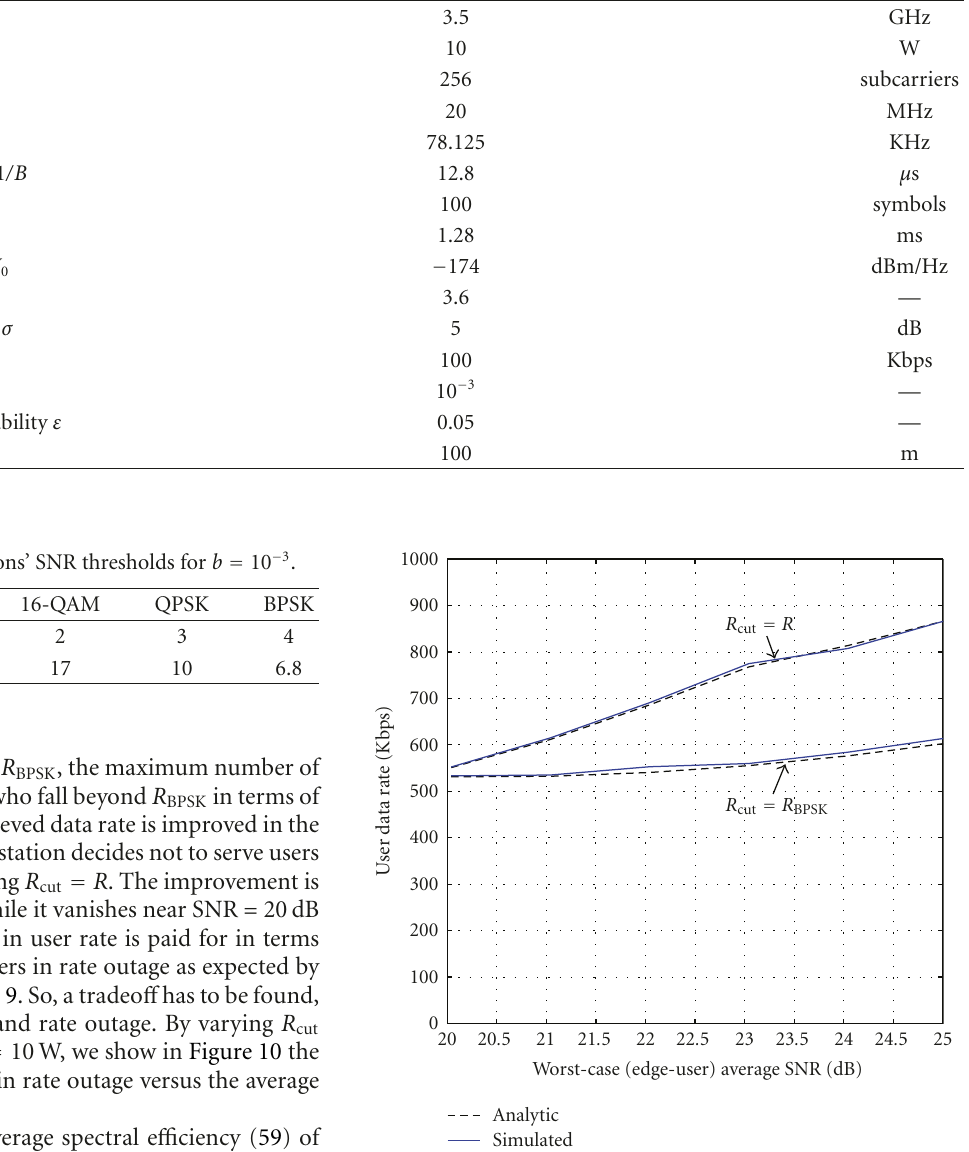
Table 2: Simulation parameters’ values.